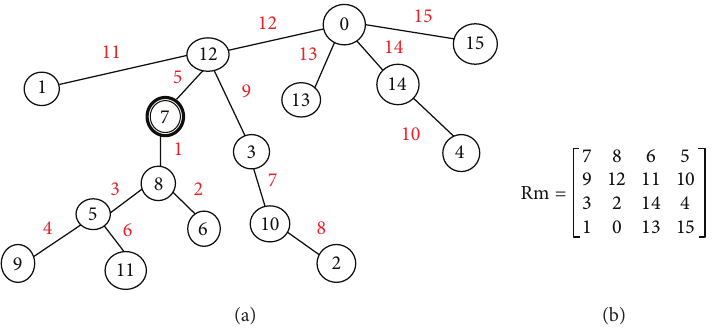
Figure 2: (a) Graceful graph. (b) Rm matrix. Table 1: Graceful graph